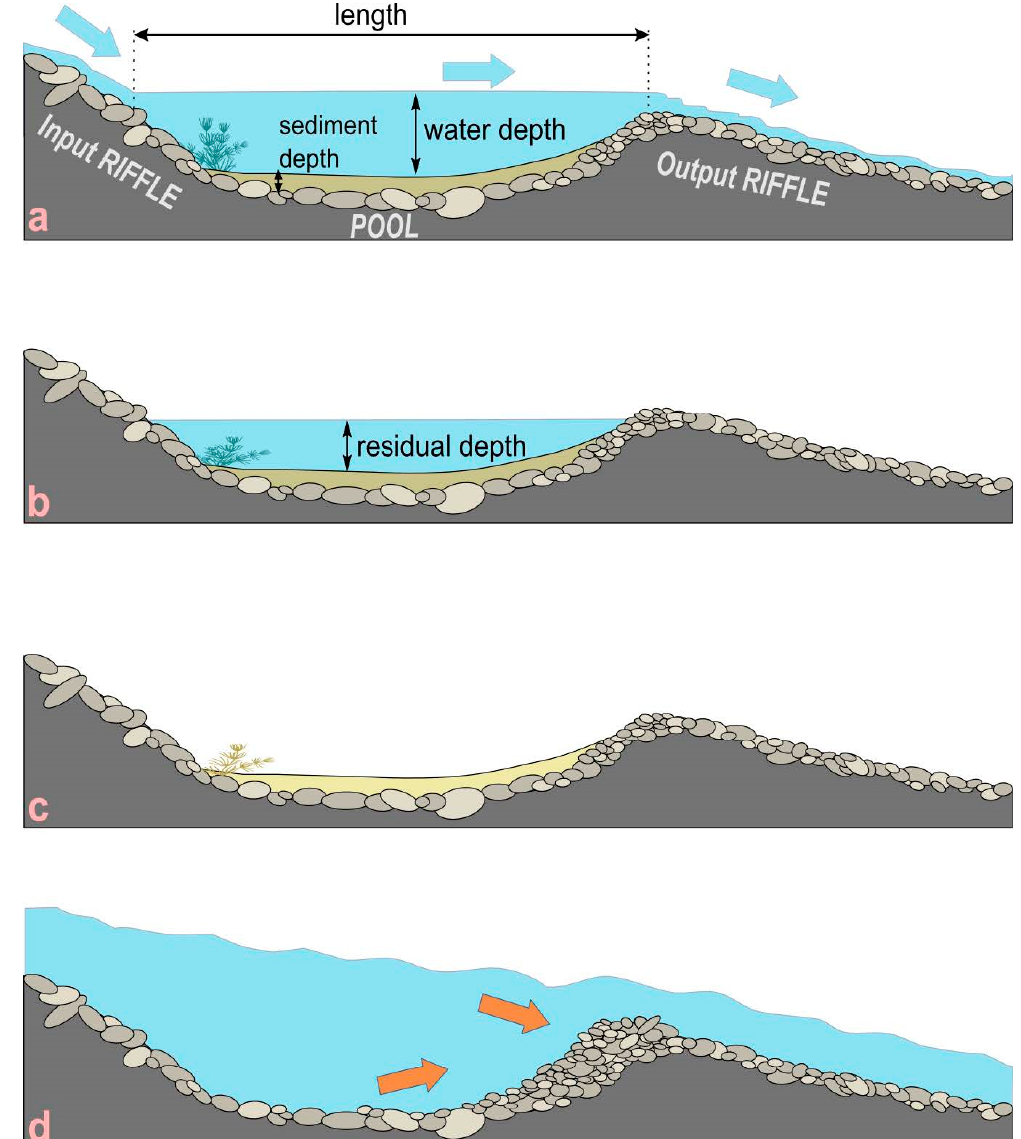
Figure 3. General geomorphological characteristics before ( a ), during ( b ), and after ( c ) the formation of an isolated pool, and with flow resumption ( d ). Blue arrows: water flow direction. Orange arrows: substrate mobilization direction. Modified from Reference